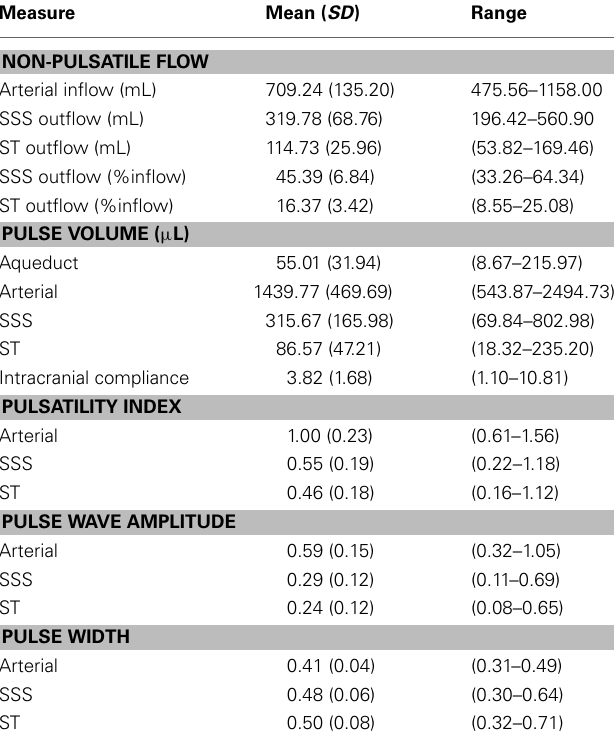
Table 2 | Means and standard deviations for both pulsatile and non-pulsatile flow measures. SSS, superior sagittal sinus; ST, straight sinus.